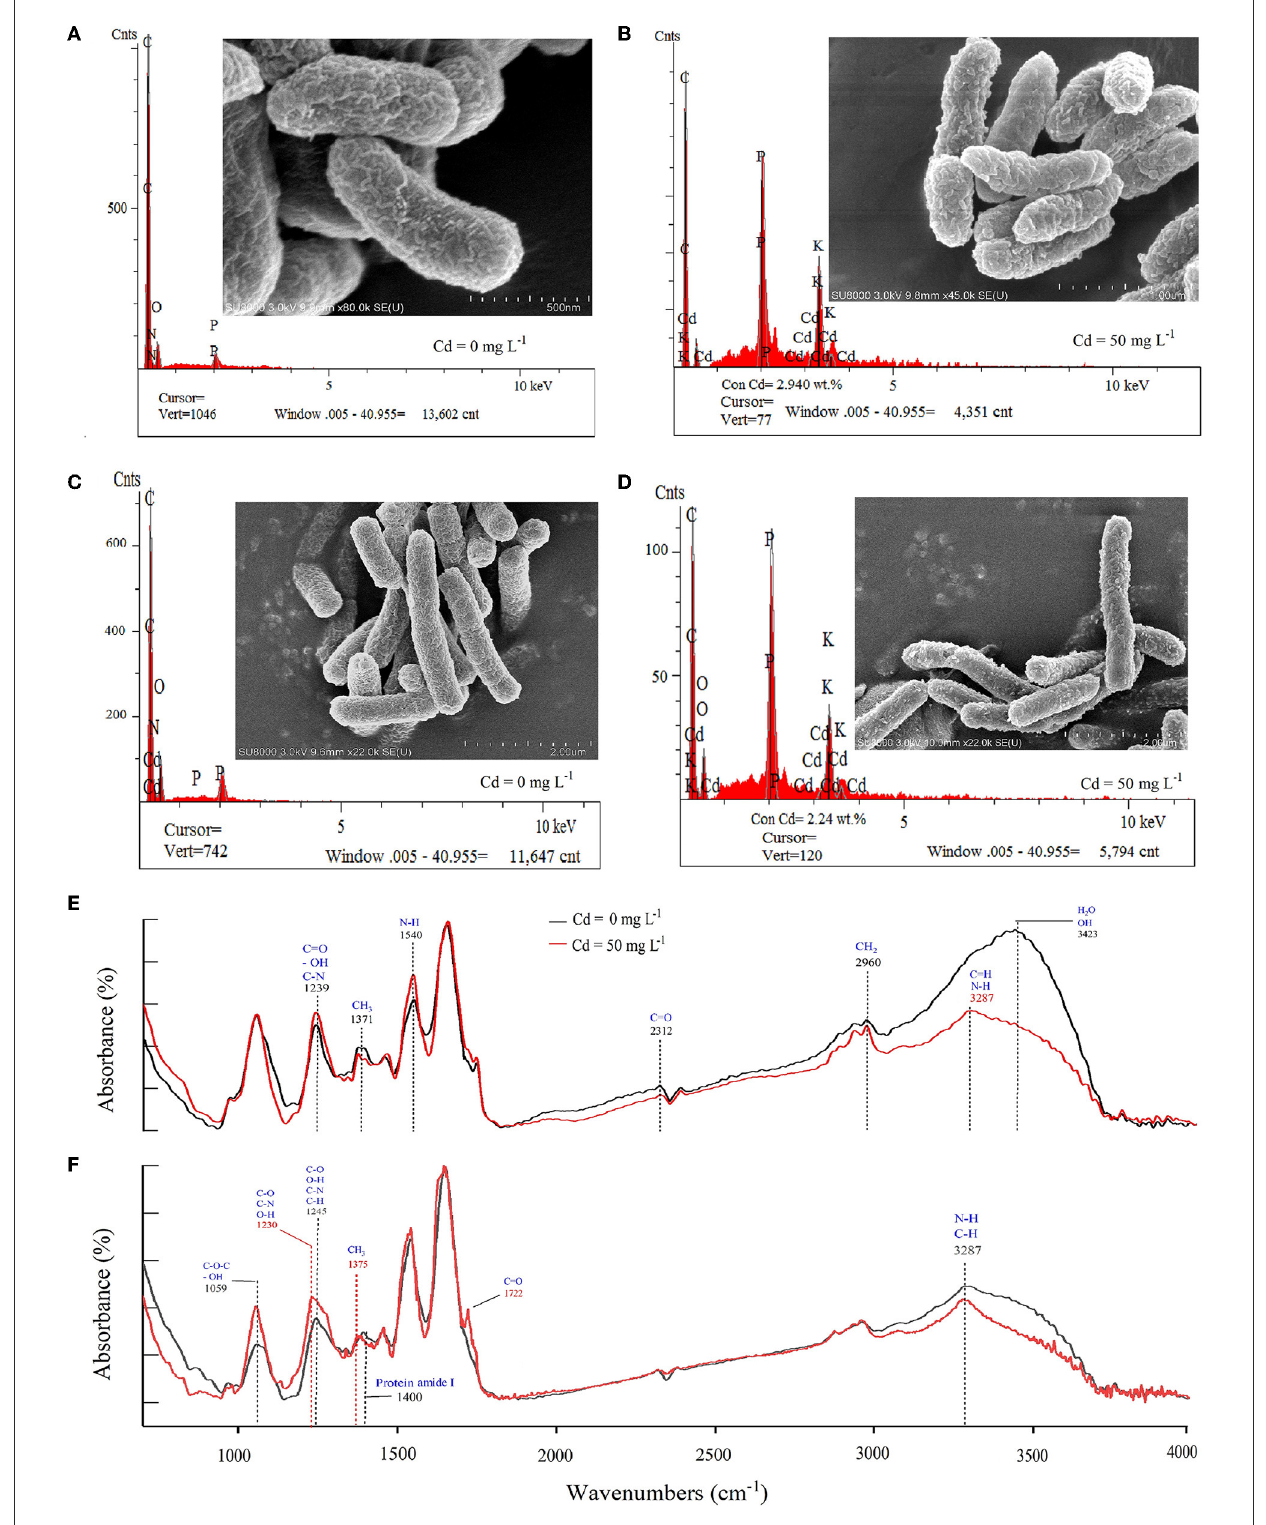
FIGURE3 (A–D) Appearance and Cd elements on the cell surface of the two bacterial strains using SEM combined with the EDS analysis. (A) Pseudomonas putida 23483 without Cd solution. (B) Pseudomonas putida 23483 exposure to Cd solution (50mg L − 1 ) for 48h. (C) Bacillus sp. GY16 without Cd solution. (D) Bacillus sp. GY16 exposure to Cd solution (50mg L − 1 ) for 48h. (E, F) Functional groups on the cell surface of the microbial strains using the FTIR analysis. (E) Pseudomonas putida 23483. (F) Bacillus sp. GY16. The red lines represent strains without Cd solution, and the black lines represent strains exposed to Cd solution (50mg L − 1 ) for